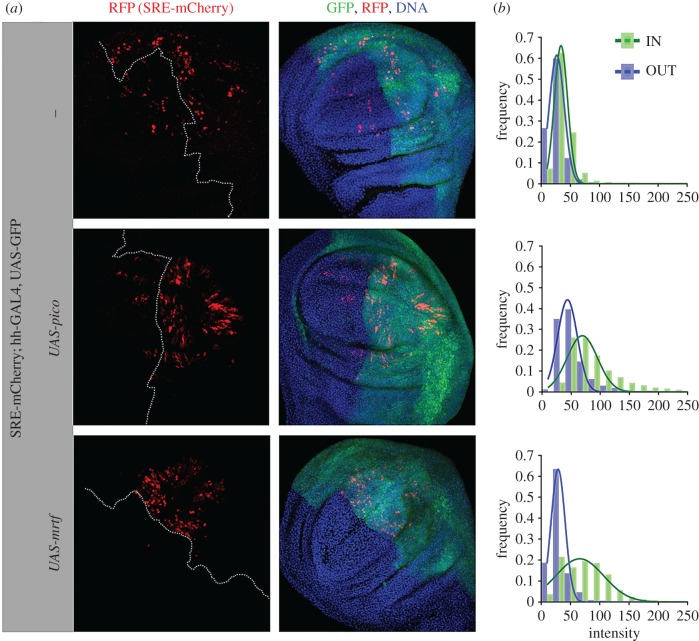
Overexpression of mrtf or pico induces SRE-mCherry expression. (a) Shown are representative images of an apical view of wing discs overexpressing mrtf or pico in the posterior compartment of third instar wing imaginal discs (marked with GFP) using hh-GAL4. GFP labels hh-GAL4 expressing cells (in green), anti-RFP antibody staining reveals SRE-mCherry distribution (in red), TOPRO-3 staining reveals DNA (in blue). For clarity, a dotted line in the images showing SRE-mCherry alone indicates the position of the anterior/posterior boundary. (b) mrtf and pico induce SRE-mCherry expression in vivo. Shown are graphs of the distribution of SRE-mCherry signal intensities inside (IN) or outside (OUT) GFP-labelled compartments (from z-stacks of at least 10 wing discs). Levels of SRE-mCherry were noticeably elevated in the posterior half of discs expressing mrtf or pico.